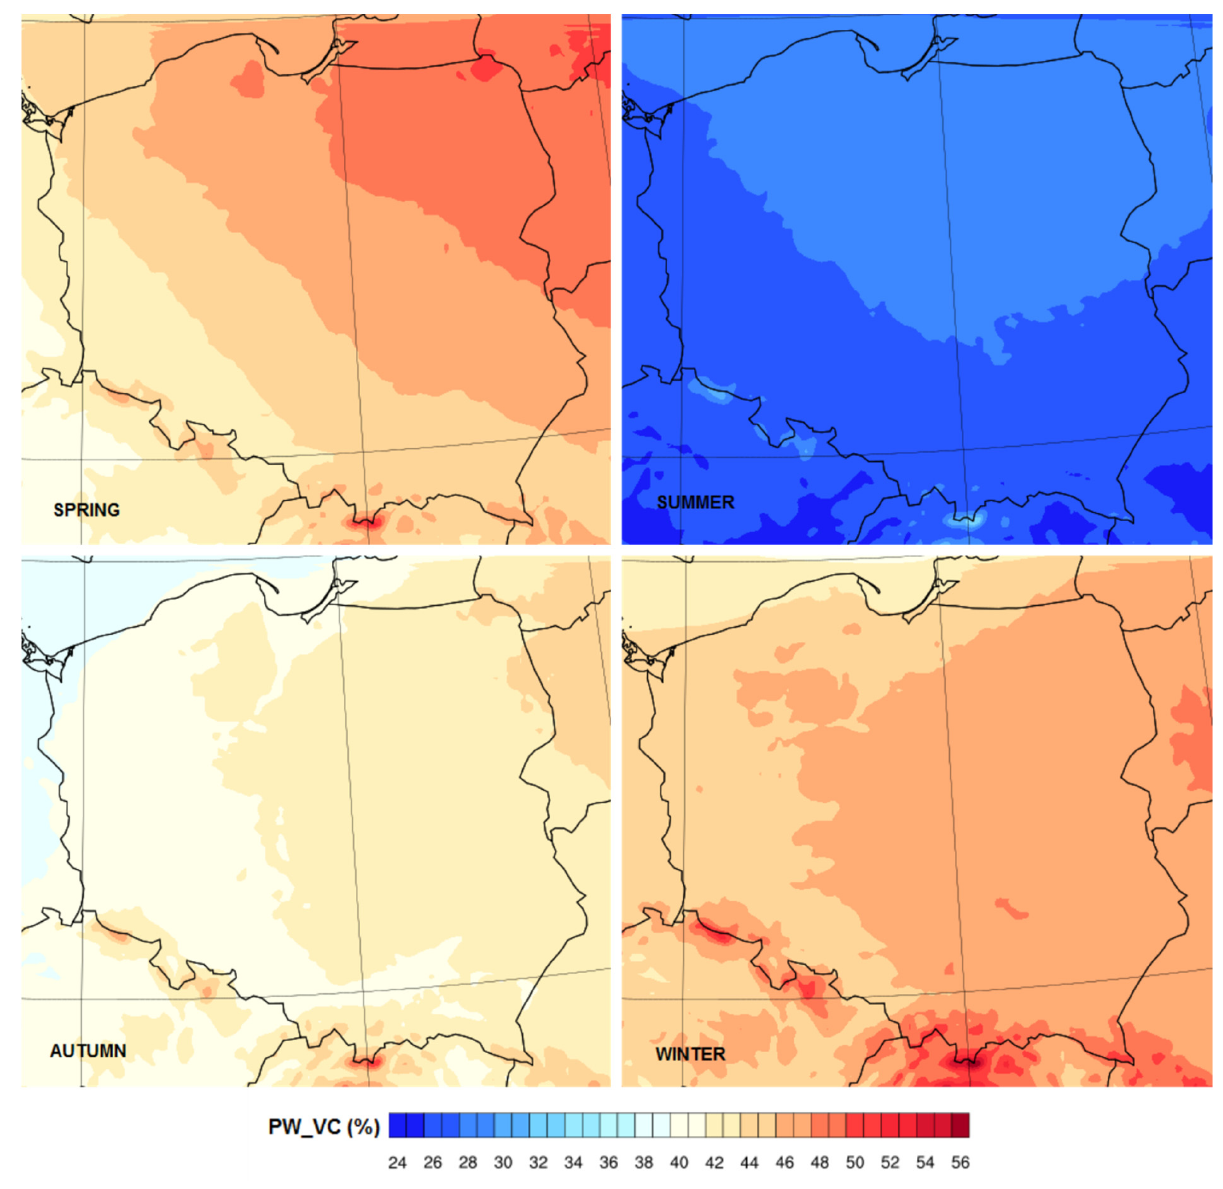
Figure 8. Variability coefficient (%) of PW seasonal value over